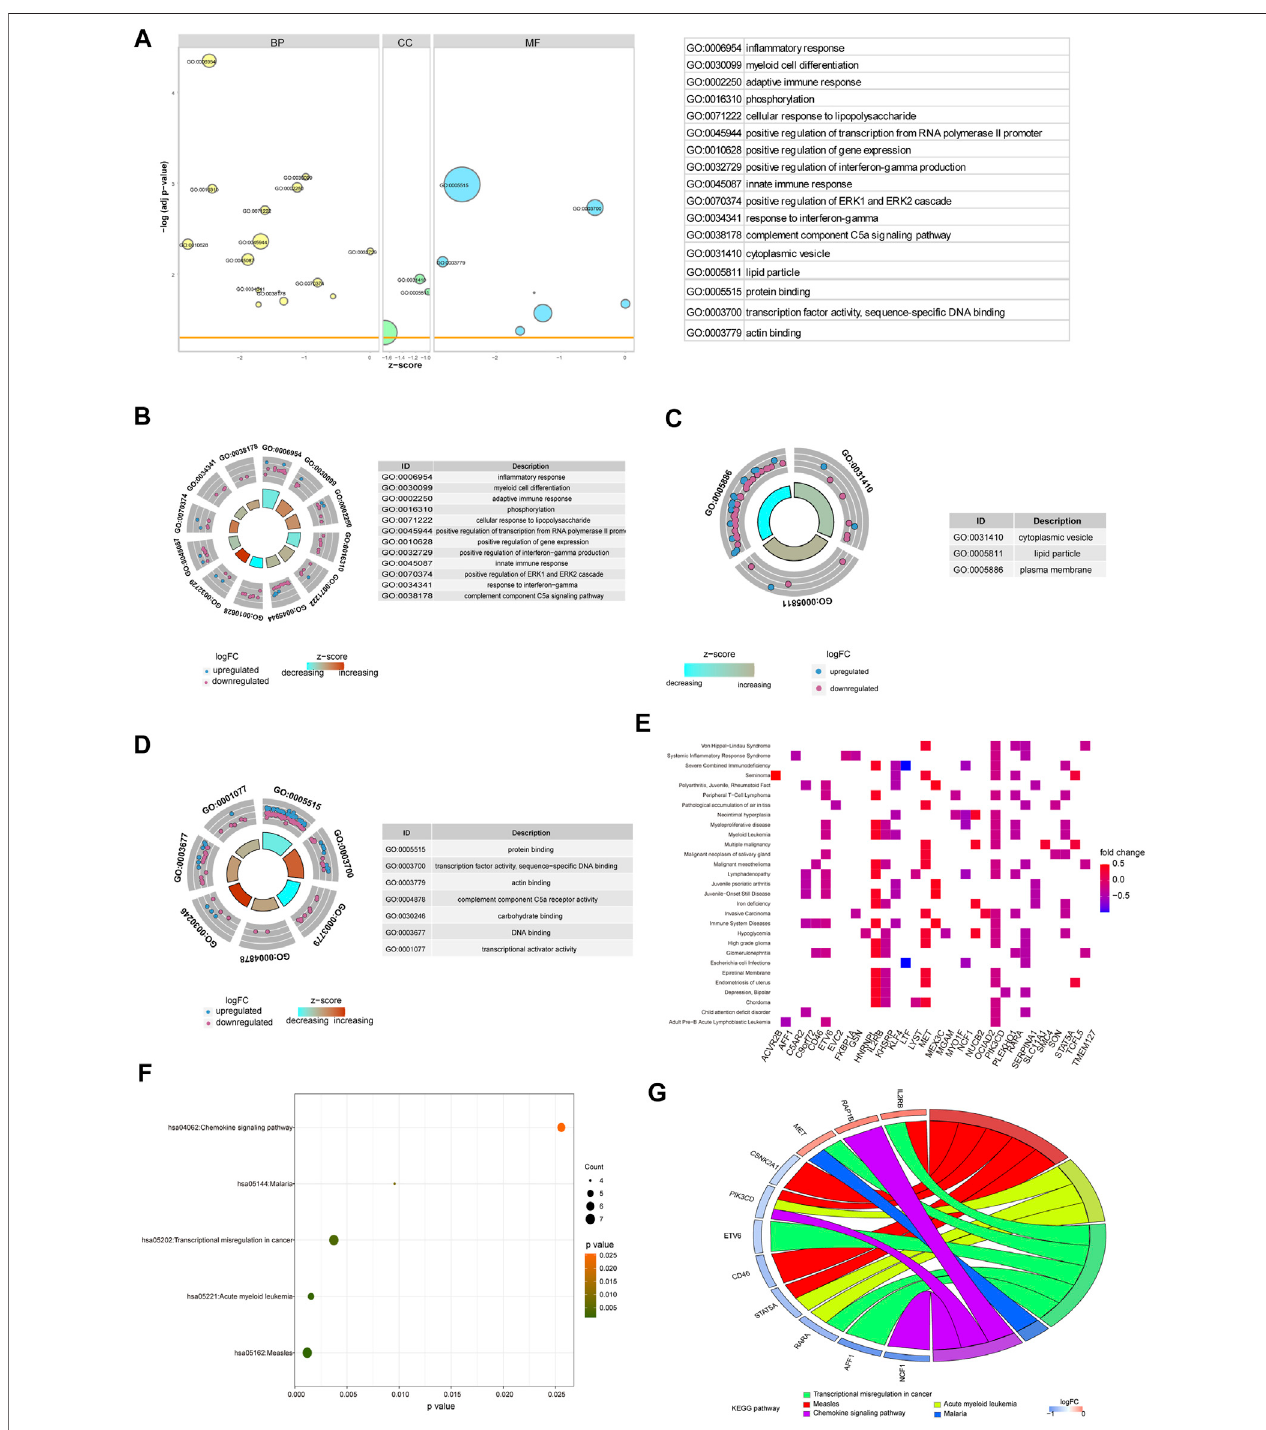
FIGURE6 | Enrichment analysis ofhub genes. (A) GO enrichmentanalysis ofhub genes. (B – D) BP, CC, and MF for enrichment analysis. Gene expression display ofthe fi rst12results ofBP,the fi rstthree results ofCC, and the fi rst eight resultsofMF in enrichment analysis.The node colorindicates the geneexpression level,purple indicatestheupregulationofgeneexpression,andblueindicatesthedownregulationofgeneexpression. (E) DOenrichmentanalysisofhubgenes.Thehorizontalaxisis the gene name, and the vertical axis is the disease name. Color indicates gene expression level, red indicates gene upregulation, and blue indicates gene downregulation. (F) KEGG enrichment analysis results of hub genes, in which node color indicates the signi fi cance level of pathway enrichment and node size indicates the number of genes enriched in the pathway. (G) For the fi rst fi ve enrichment results in KEGG enrichment analysis, the rectangular color indicates the gene expression level, red indicates the upregulation of gene expression, and blue indicates the downregulation of gene expression. Line colors identify different pathways.